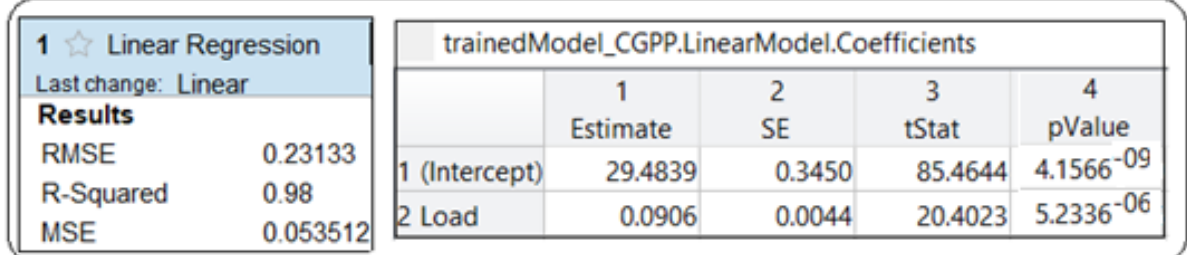
Figure 1. CGPP prediction results from regression learner.